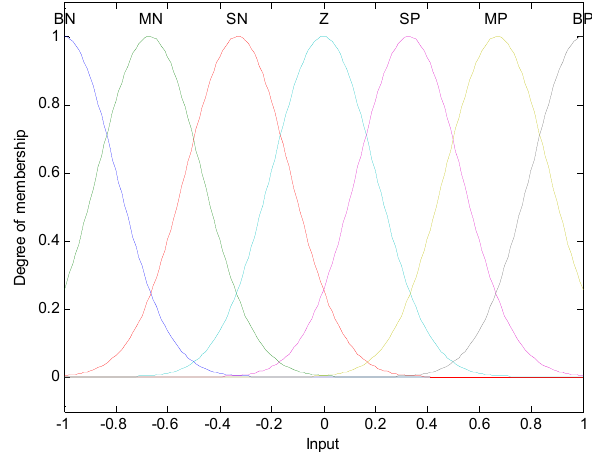
Figure 4. The seven memberships of symmetrical Gaussian functions.